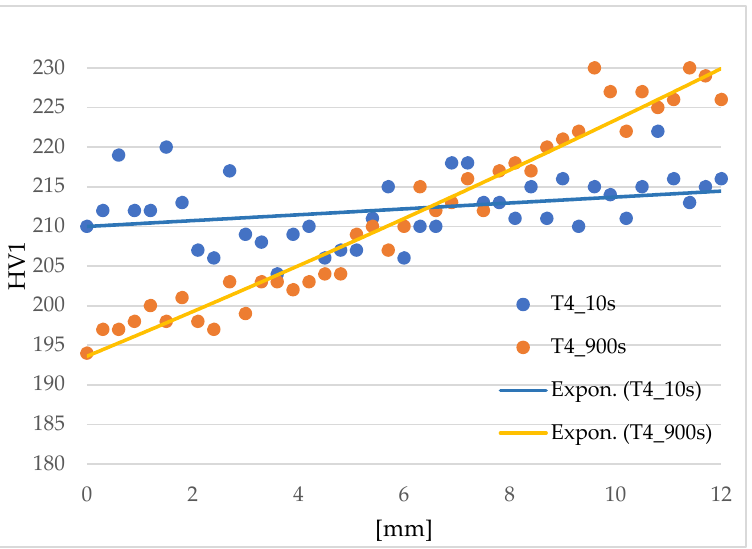
Figure 13. Hardness profile through the transition area of 20MnAl steel samples: 10s_T and 900s_T.